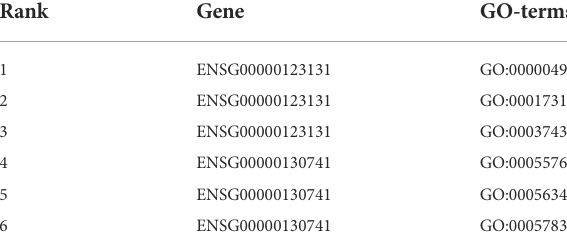
TABLE 7 Top-ranked gene ontology terms selected from GGA